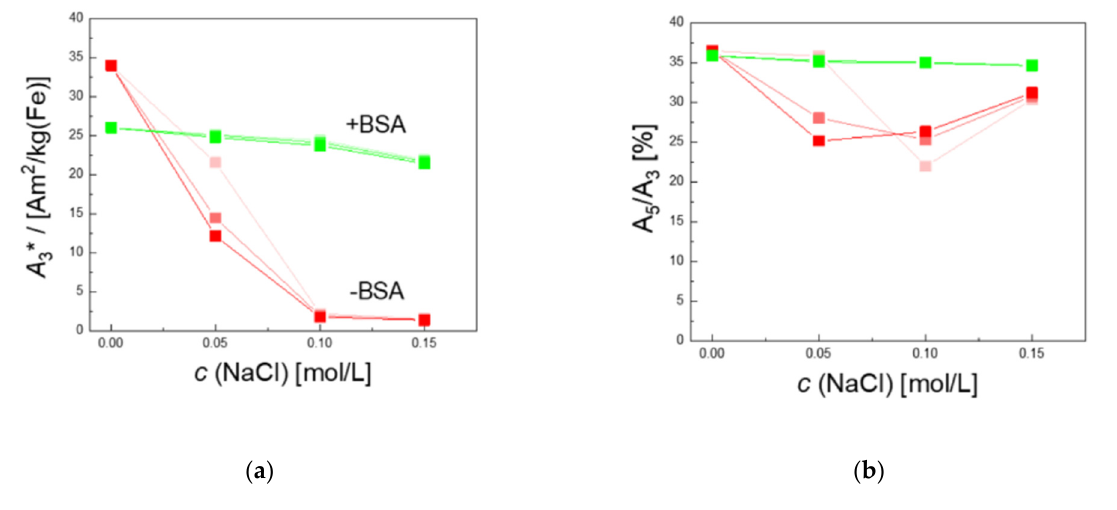
Figure 8. Colloidal stability of MNP in NaCl solution after different incubation times as measured by MPS. MPS parameter A 3 * ( a ) of uncoated (red symbols) and BSA-coated MNP (green symbols) at different NaCl concentrations after 2 h, 1 day, and 1 week of incubation (symbols from bright to dark with increasing time). Nearly no changes (less than 10%) of the specific MPS amplitude A 3 * were observed in the BSA-coated MNP, indicating colloidal stability up to physiological saline concentrations of 0.15 mol/L. By contrast, the uncoated MNP show a strongly reduced stability visible in the strong A 3 * reduction at NaCl concentrations below 0.10 mol/L. As for A 3 *, the corresponding parameter A 5 / A 3 ( b ) remains unchanged up to physiological NaCl concentration for BSA-coated MNP, while for uncoated MNP, a reduction in the parameter is visible. Since A 5 / A 3 is concentration-independent, only a very small fraction (below 5% as estimated from the A 3 * drop) of not completely aggregated MNP are contributing to A 5 / A 3 .